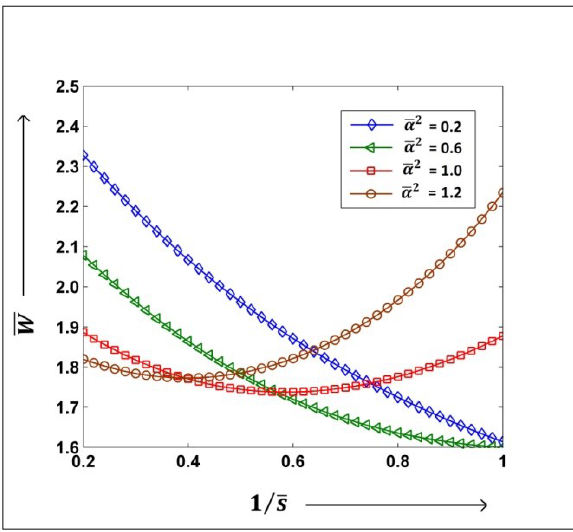
Fig. 10: Lifting force vs. Thermal parameter for different values of the magnetic parameter at 1/¯ s = 1, ¯ α 2 = 1, ¯ β = 1.3, ¯ γ 2 = 1.2 times the bearing may break due to overheating between the pads.